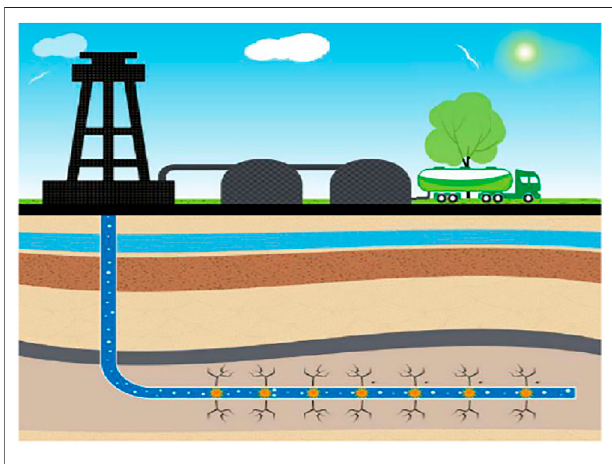
FIGURE 1 | Schematic diagram for shale